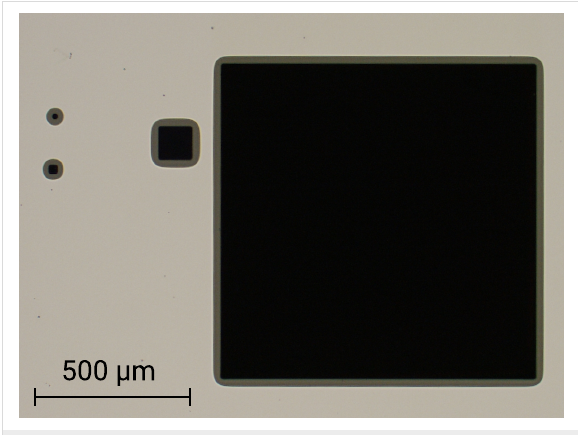
Figure 3: Microscope image of etched